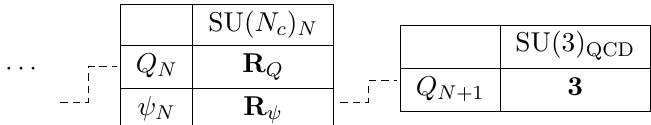
Table 5 . The termination of the chain of connected modules, which breaks the U(1) A symmetry by the QCD anomaly. The model can be made consistent with a Z ( j =1 (cid:1)(cid:1)(cid:1) N ) m symmetry, de(cid:12)ned in